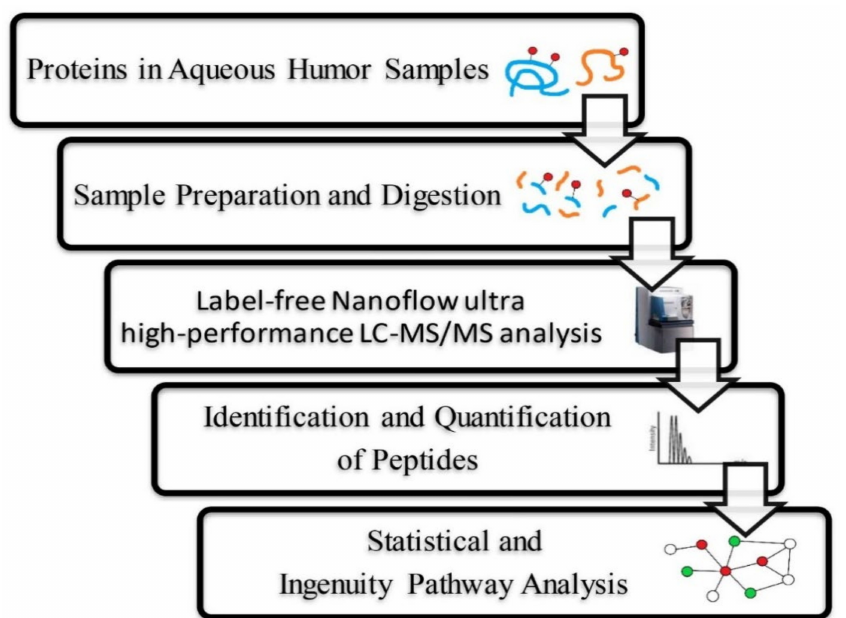
Figure 1. Label-free Nanoflow UHPLC-MS/MS analytical workflow for the proteomic analysis of human aqueous humor. Samples were digested using trypsin and were analyzed using an LTQ-Orbitrap DiscoveryTM hybrid mass spectrometer (Thermo Electron). Proteins were identified and quantified using the SEQUEST algorithm followed by analysis using Xcalibur 2.0 SR1 (Thermo